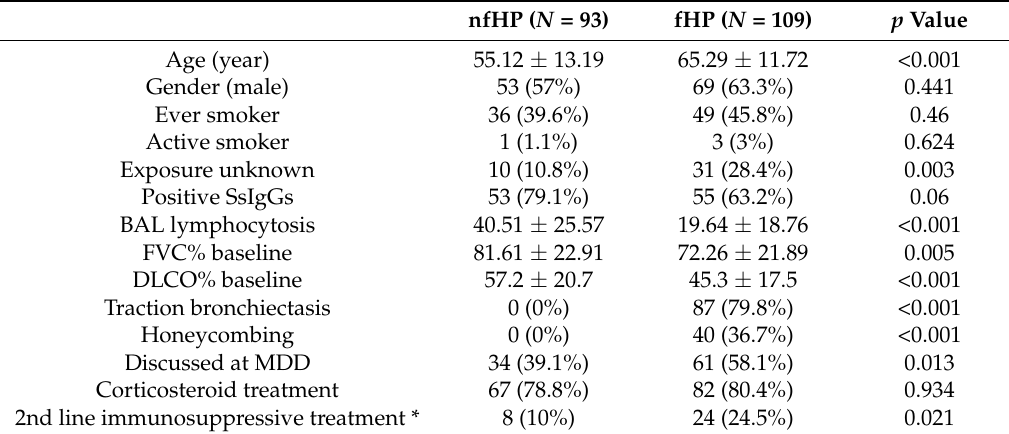
Table 1. Baseline characteristics for nfHP and fHP at